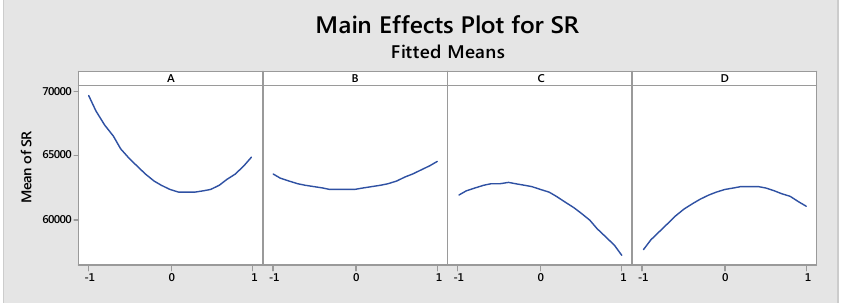
Fig. 4. Main Effects Plot for